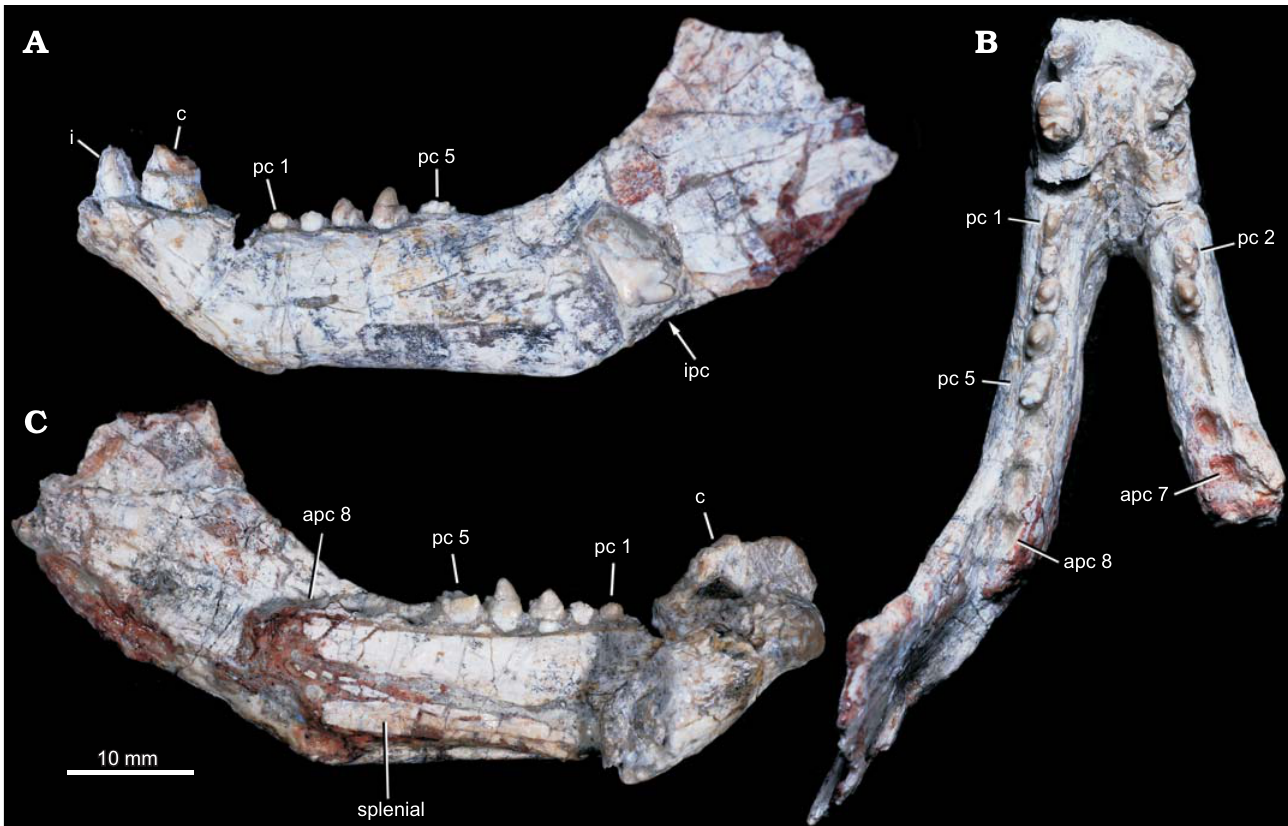
Fig. 2. Probainognathian eucynodont Candelariodon barberenai Oliveira, Schultz, Soares, and Rodrigues, 2011 (holotype, MMACR PV-0001-T) from the Middle–Late Triassic of Rio Grande do Sul state, Brazil. Lower jaw with partial dentition in left lateral ( A ), occlusal ( B ), and right medial (with part of right dentary detached) ( C ) views. Abbreviations: apc, postcanine alveolus; c, lower canine; i, lower incisor; ipc, isolated postcanine; pc, lower